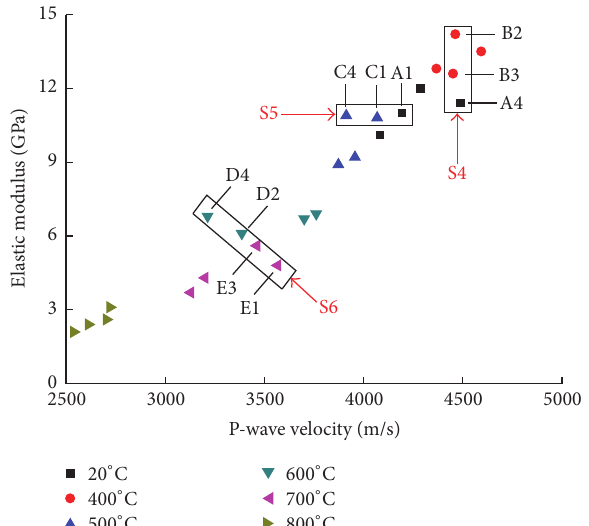
Figure 7: UCS variations after F-T cycling.